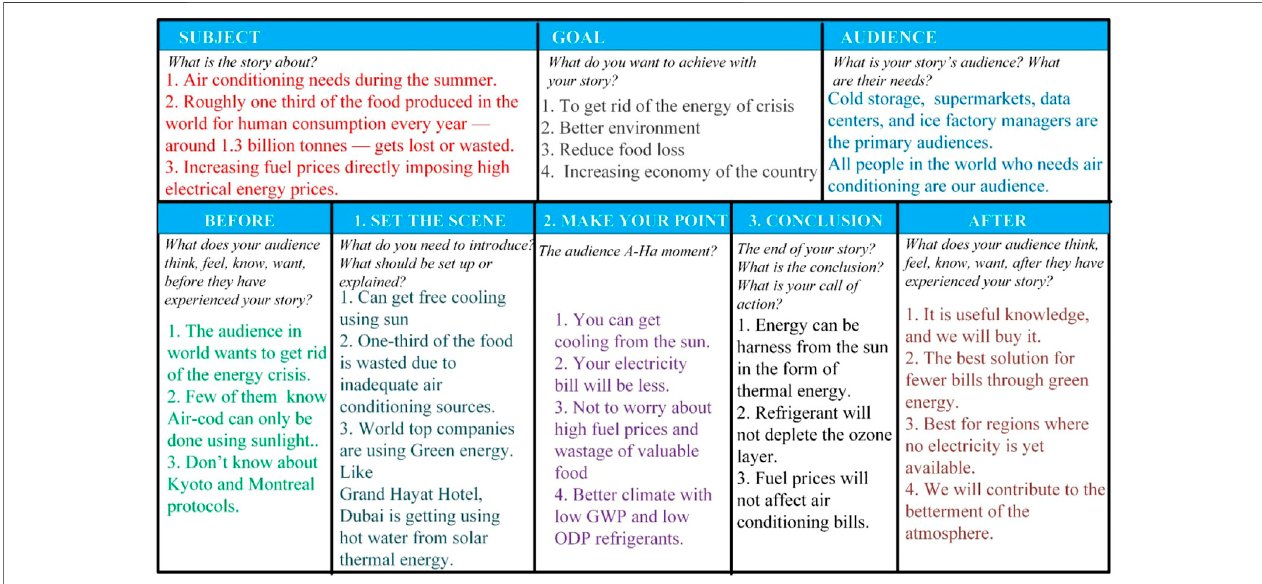
FIGURE 15 | Story telling Canvas (Van Der Pijl et al., 2016a; Design a Better Business, 2018).